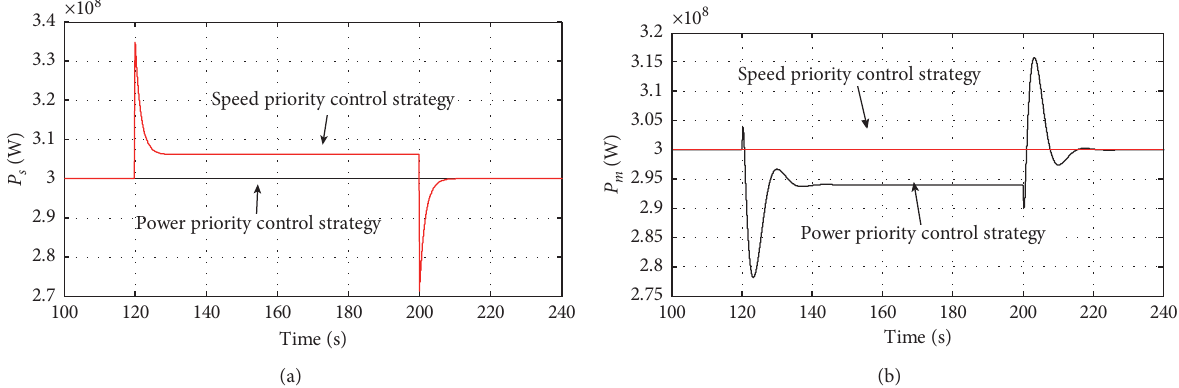
Figure 34: Active power comparison diagram when P (b) Comparison diagram of stator-side active power.